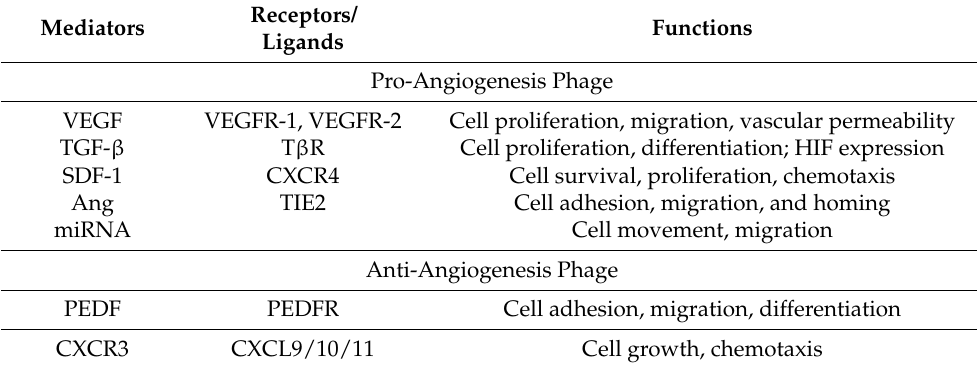
Table 1. Major factors regulating injury